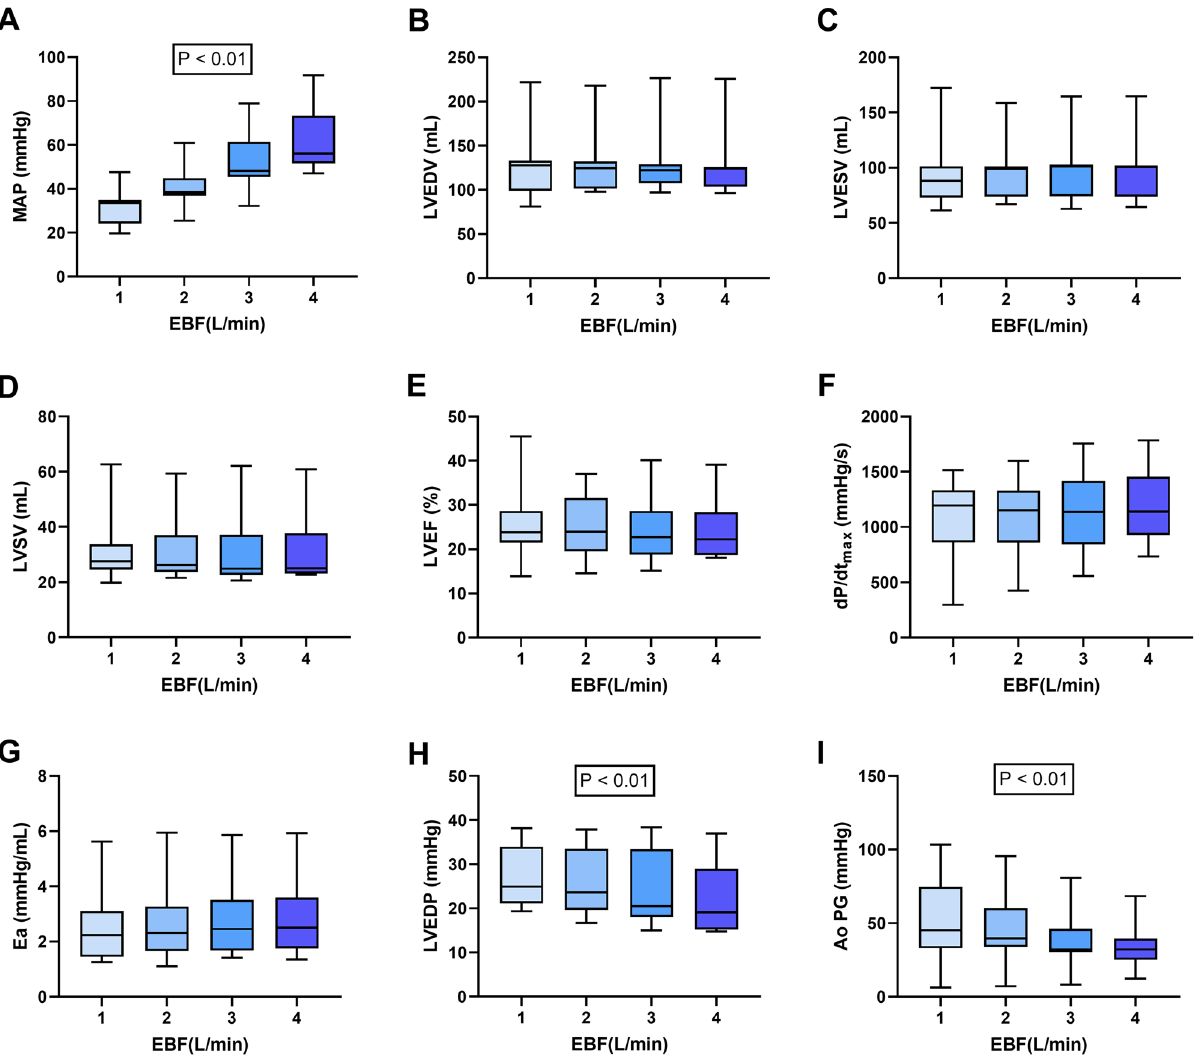
model of cardiogenic shock with aortic stenosis. ( A ) MAP, mean arterial pressure; ( B ) LVEDV, left ventricle end-diastolic volume; ( C ) LVESV, left ventricle end-systolic volume; ( D ) LVSV, left ventricle stroke volume; ( E ) LVEF, left ventricle ejection fraction; ( F ) dP/dt max ; ( G ) Ea, arterial elastance; ( H ) LVEDP, left ventricle end- diastolic pressure; ( I ) AoPG, peak aortic pressure